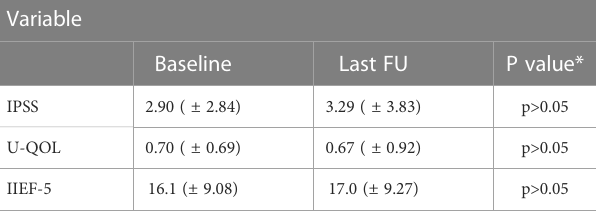
TABLE 4 Quality of life indicators.